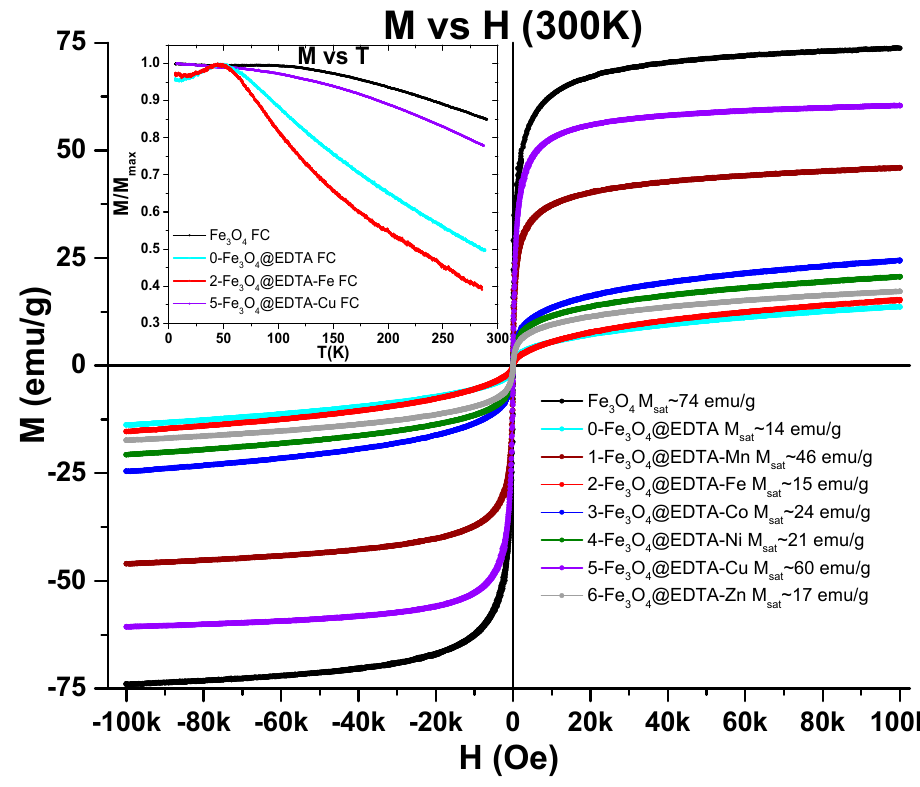
Figure 6. Magnetization curve at T = 300 K as a function of magnetic field on Fe 3 O 4 , Fe 3 O 4 @EDTA ( 0 ), Fe 3 O 4 @EDTA ‐ M 2+ [M 2+ = Mn 2+ ( 1 ), Fe 2+ ( 2 ), Co 2+ ( 3 ), Ni 2+ ( 4 ), Cu 2+ ( 5 ), Zn 2+ ( 6 )] MNPs. Inset shows the magnetization curve (normalized by its maximum) as a function of the temperature for Fe 3 O 4 , 0, 2 and 5 MNPs under a field 300 Oe. Samples with lower magnetizations present superparamagnetic behavior above a blocking temperature of ~50 K.